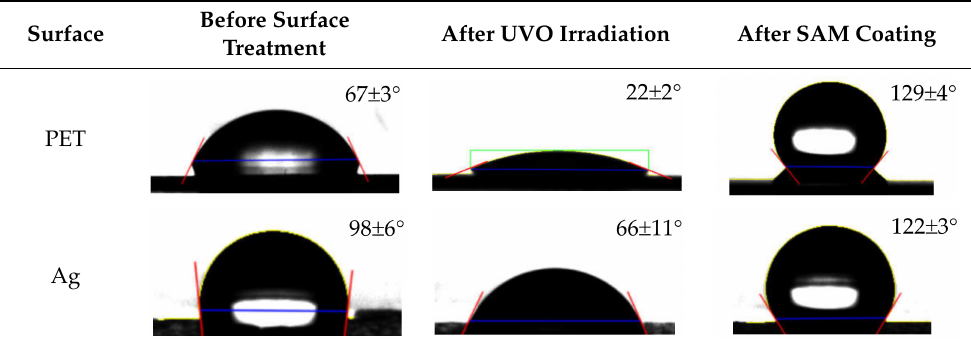
Table 1. The WCA values on PET substrate and Ag electrode before and after the surface treatments of UVO irradiation and SAM